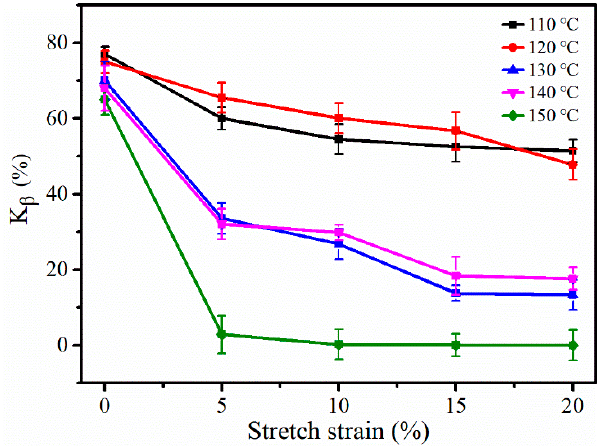
Figure 2. The K β of the iPP sheet after stretching at different temperatures.